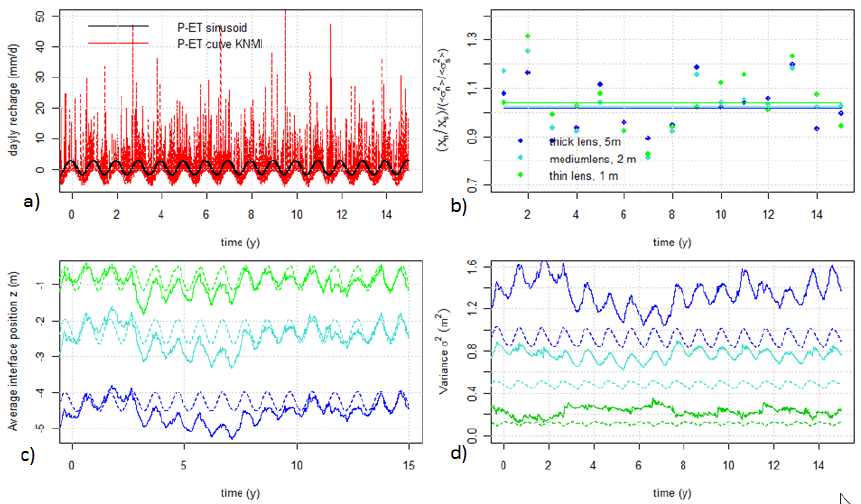
Fig. 9. (a) The recharge pattern of natural and sinusoidal recharge curves is shown. (b) The ratio between the travelled distance and variance (Eq. 22b) for individual years (dots) and averaged over 15yr (lines). (c) The centre of the mixing zone for 15yr of daily recharge ( ¯ z 1 ) and (d) the associated variance ( σ 2 n ) for lenses with a different average thickness.